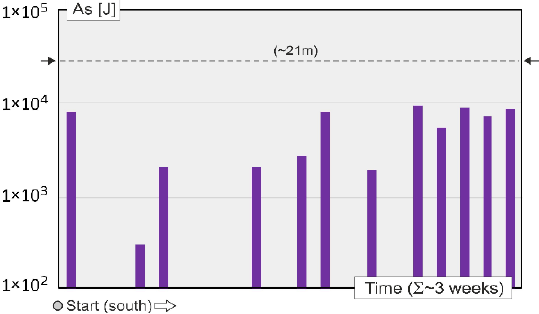
Figure 13. Histogram of seismic energy release — bottom heading Y#2.